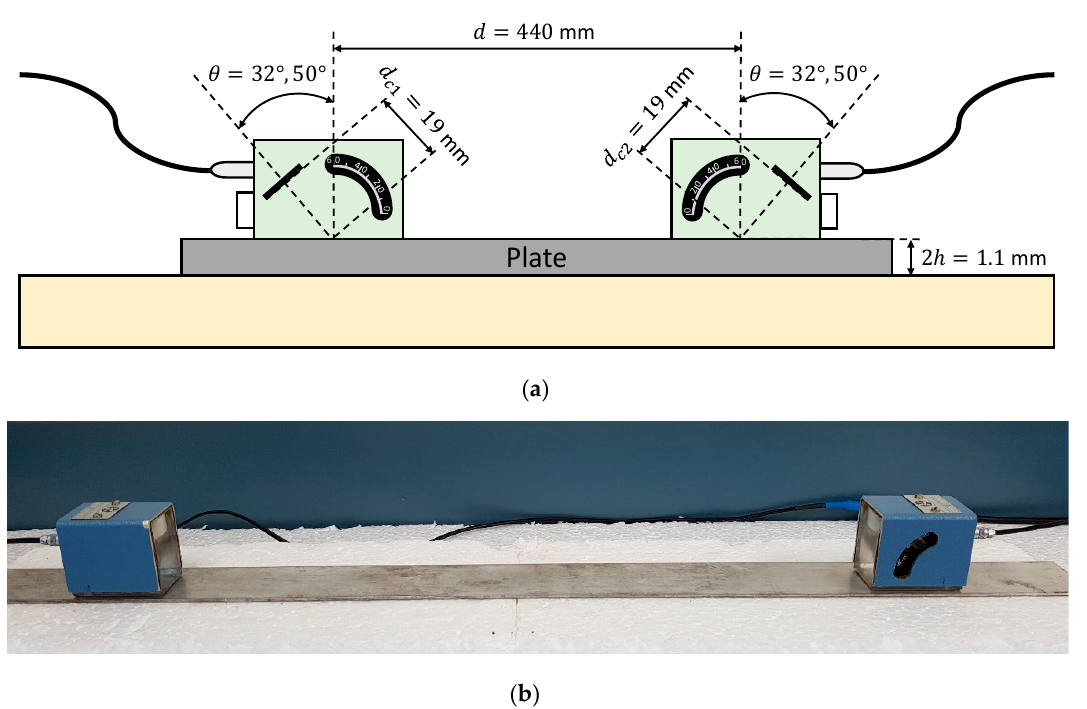
Figure 5. Direct contact setup with variable angle beam transducers to measure the stainless steel plate: ( a ) Schematic; ( b ) Photograph.